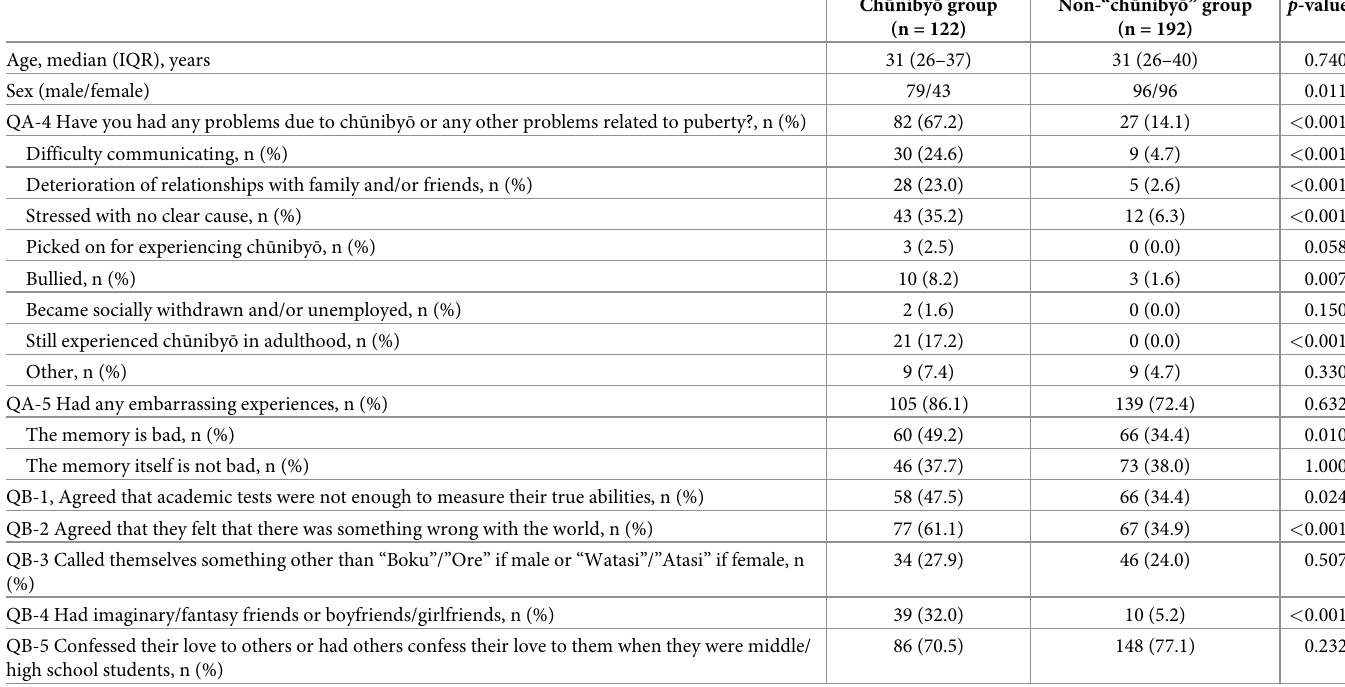
Table 2. Comparisons between the ch ū niby ō group and the non-ch ū niby ō